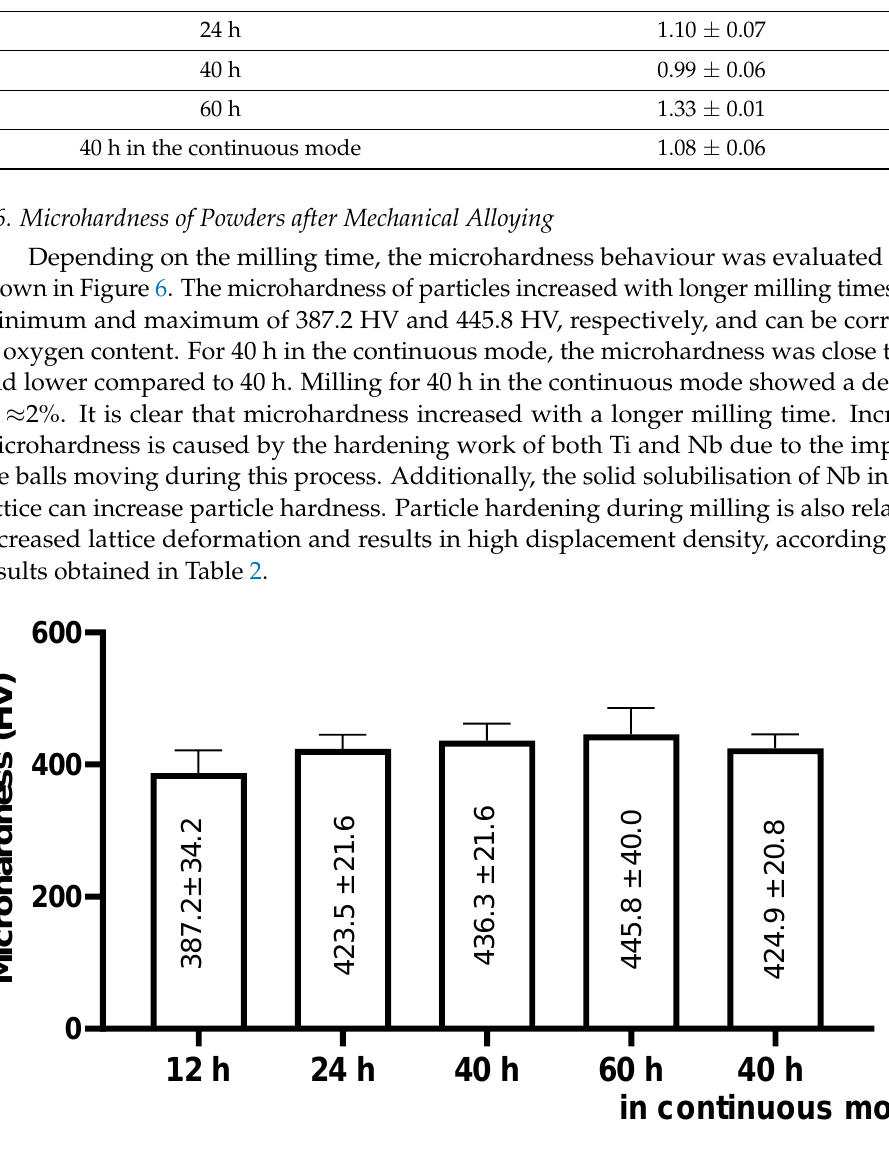
Figure 6. Evolution of microhardness for Ti–Nb–Mo powders at different milling times.